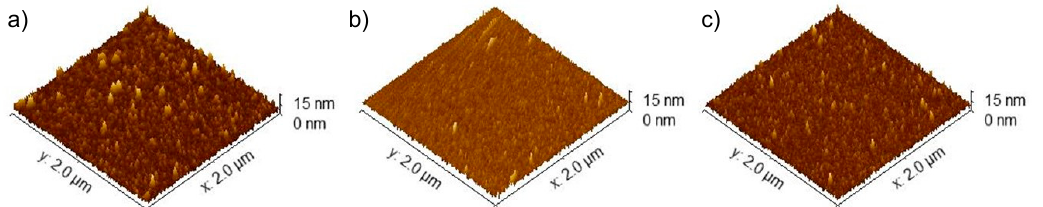
Table 1. Summary of mechanical properties of a-C:H coating. Figure 4. AFM images of a-C:H coatings on Si substrate with deposition power of ( a ) 10 W, ( b ) 25 W, and ( c ) 40 W.